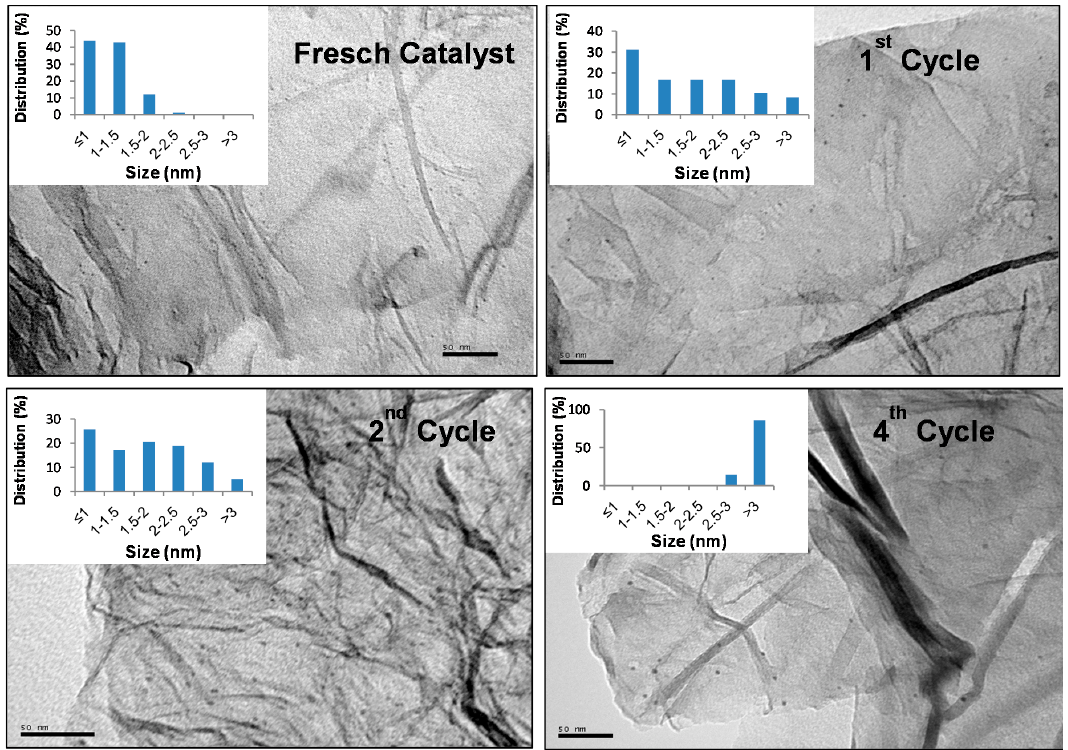
Figure 10. Selected transmission electron microscopy (TEM) images of the fresh and the reused catalysts after 1st, 2nd and 4th cycles and plots of the distribution sizes of Pd 0 nanoparticles (insets).